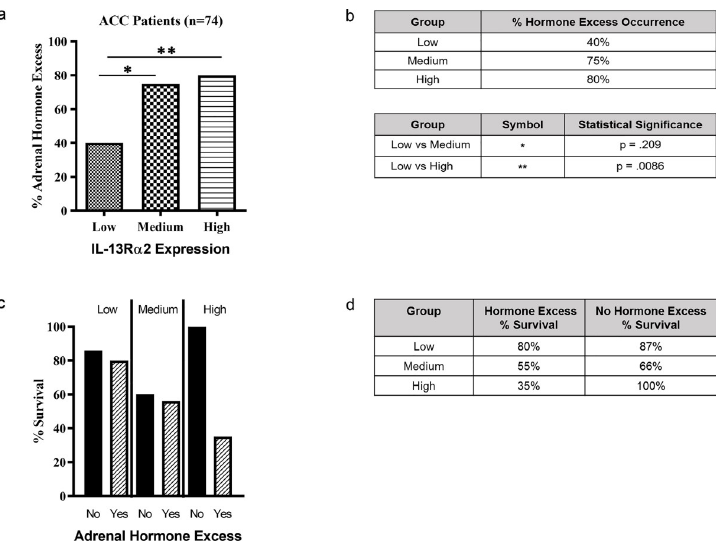
Fig 4. Comparison between IL-13R α 2 expression and adrenal hormone excess. 74 ACC subjects were divided between high (n = 27), medium (n = 26), and low (n = 26) IL-13R α 2 expression and their relationship with hormone excess occurrence was assessed (Fig 4A and 4B). P values are shown comparing low vs. medium and low vs. high IL- 13R α 2 expression. For comparison between IL-13R α 2 expression, adrenal hormone excess and survival, and their correlation with survival in subjects who developed excess hormone and those without excess hormone was assessed (Fig 4C and 4D).